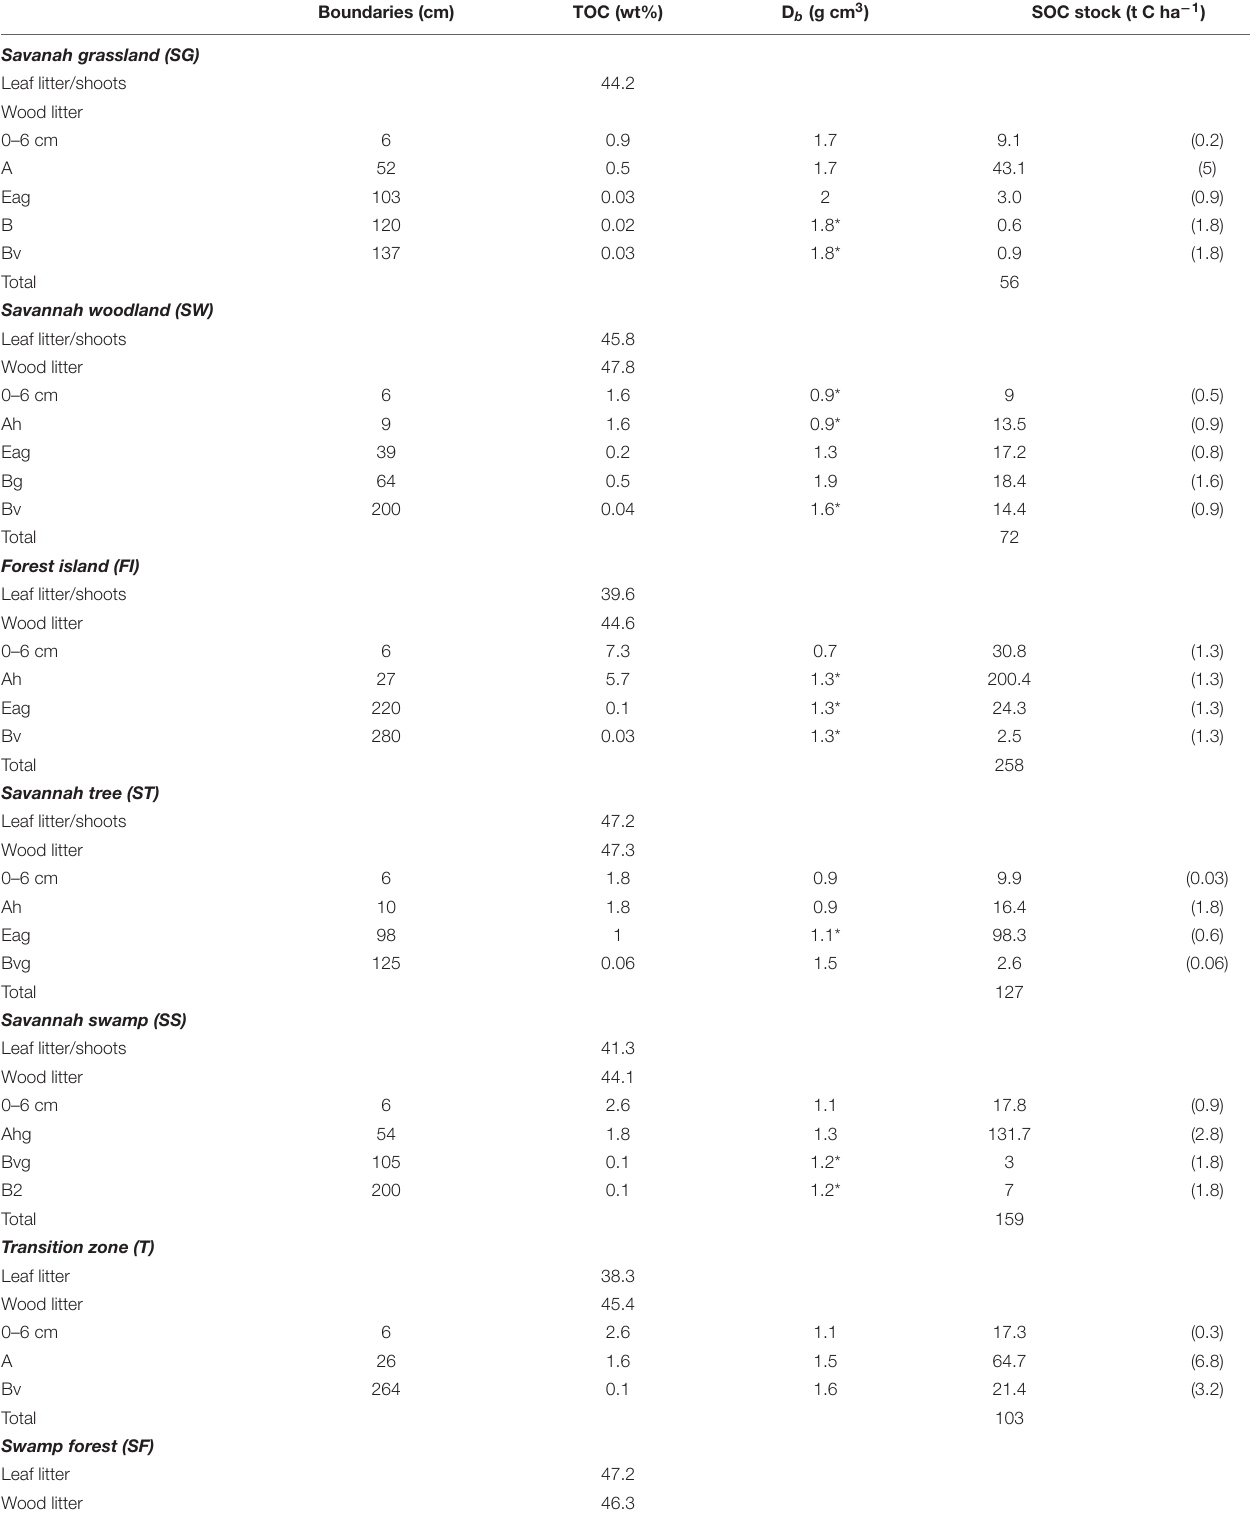
TABLE 1 | Full soil profile TOC%, bulk density and soil SOC stock for each sub-environment, parentheses indicate standard error of triplicates. Boundaries